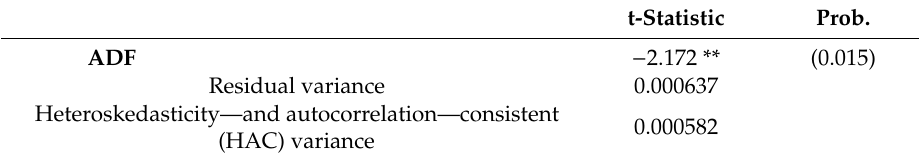
Table 5. Panel Cointegration test results with intercept and trend